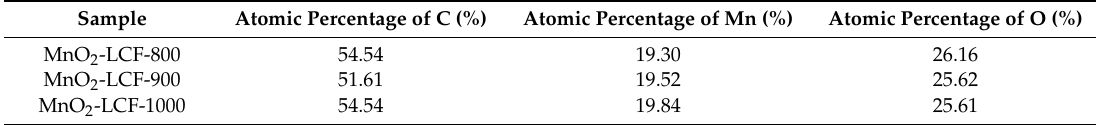
Table 2. Mn, O, and C concentrations of the MnO 2 -LCF samples, as determined from their XPS spectra.